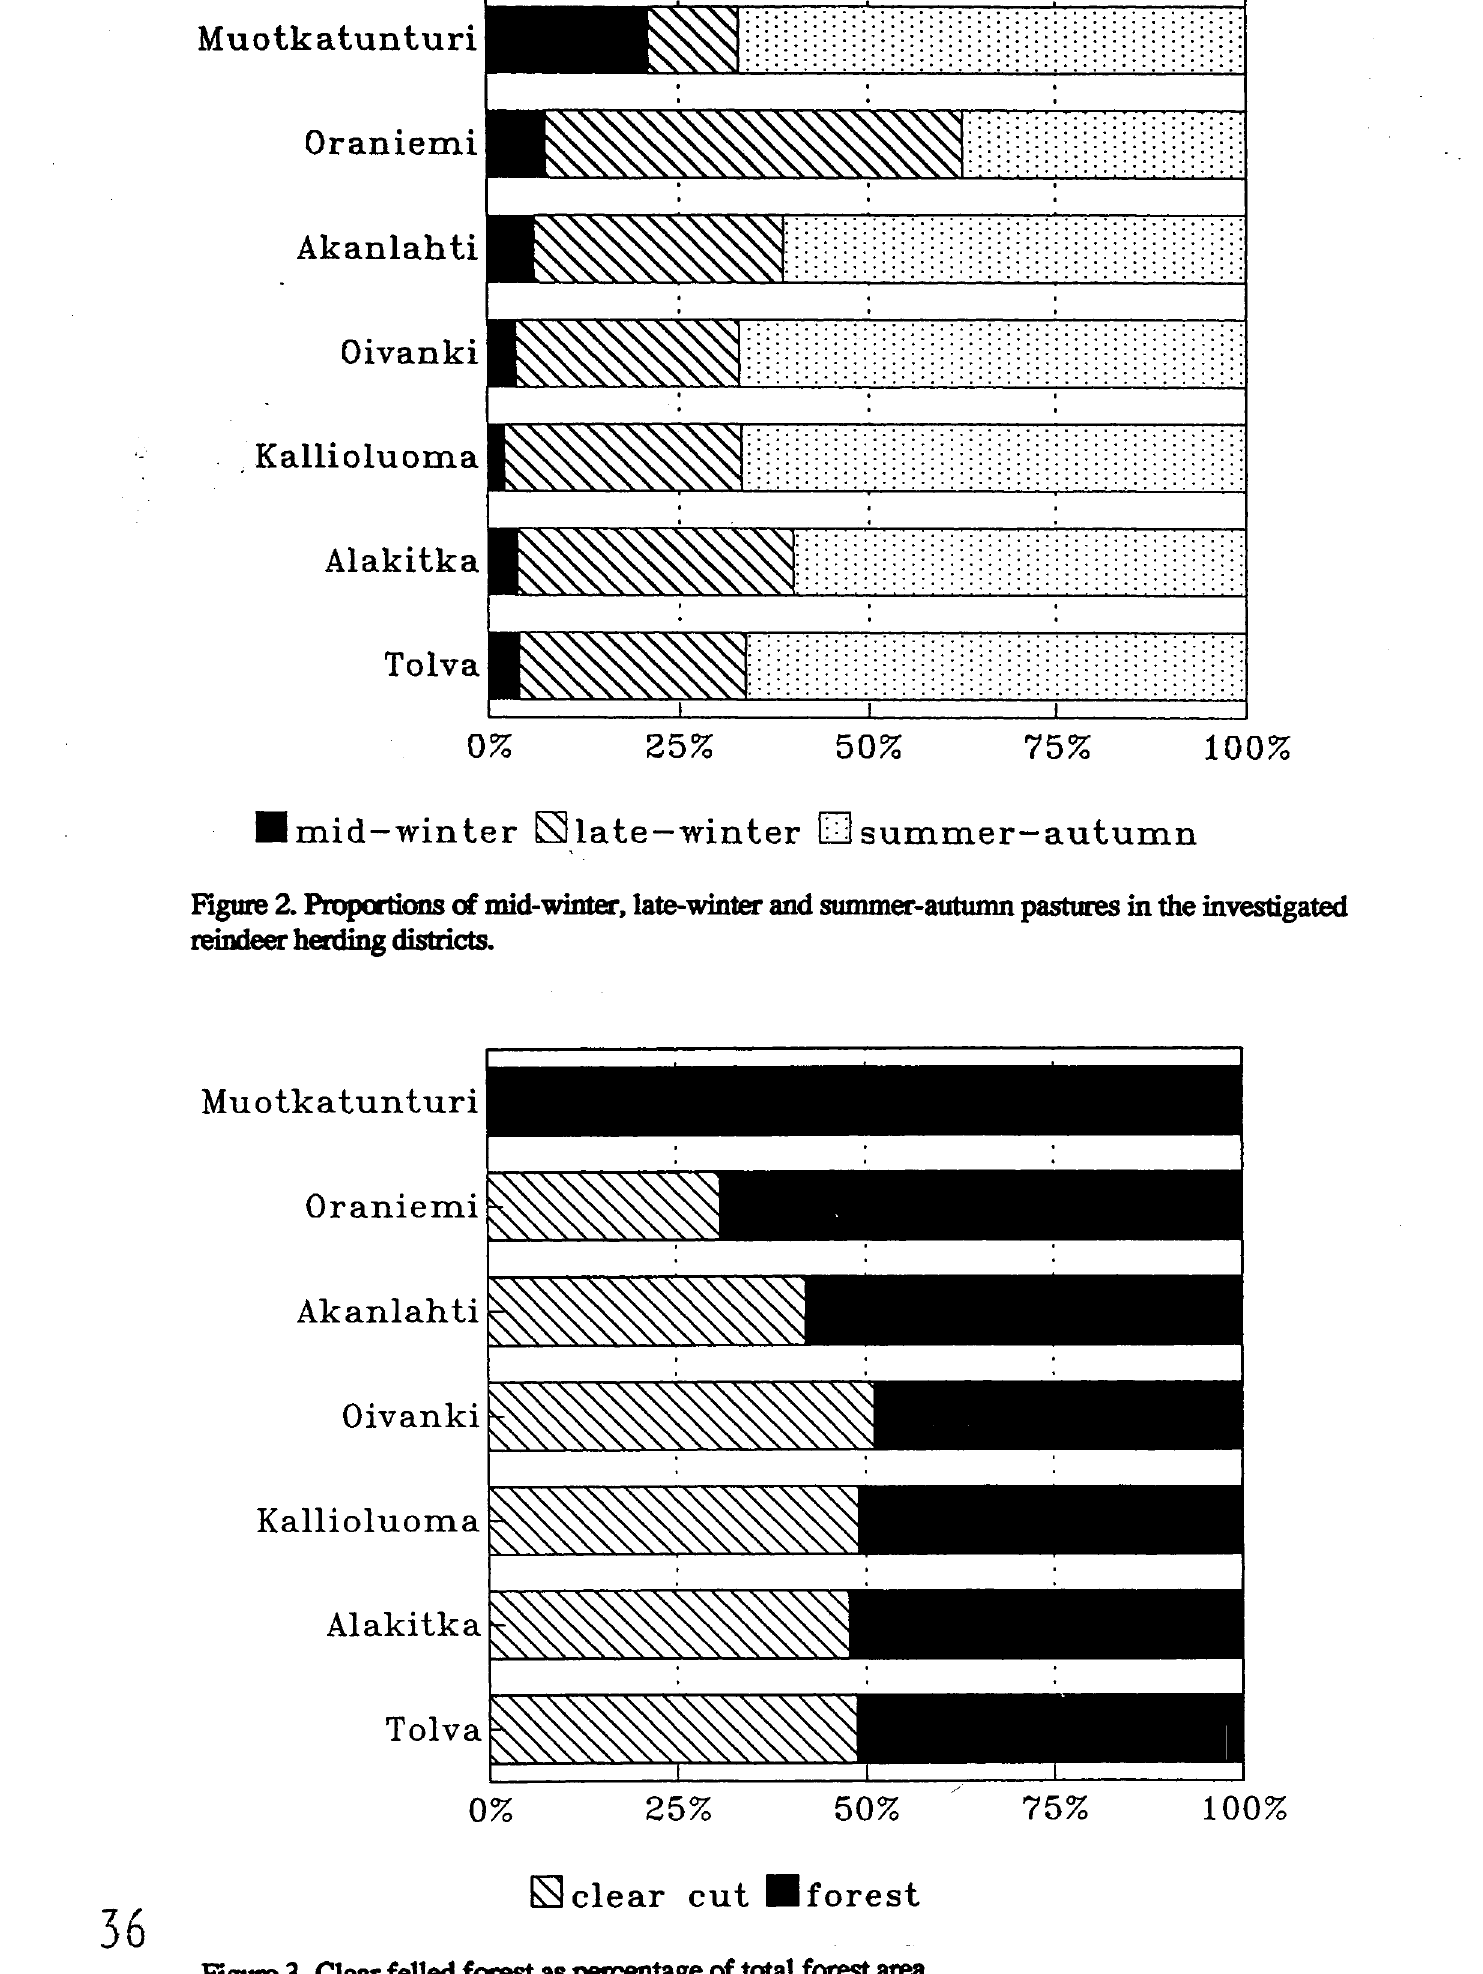
Figure 3- Clear felled forest as percentage of total forest